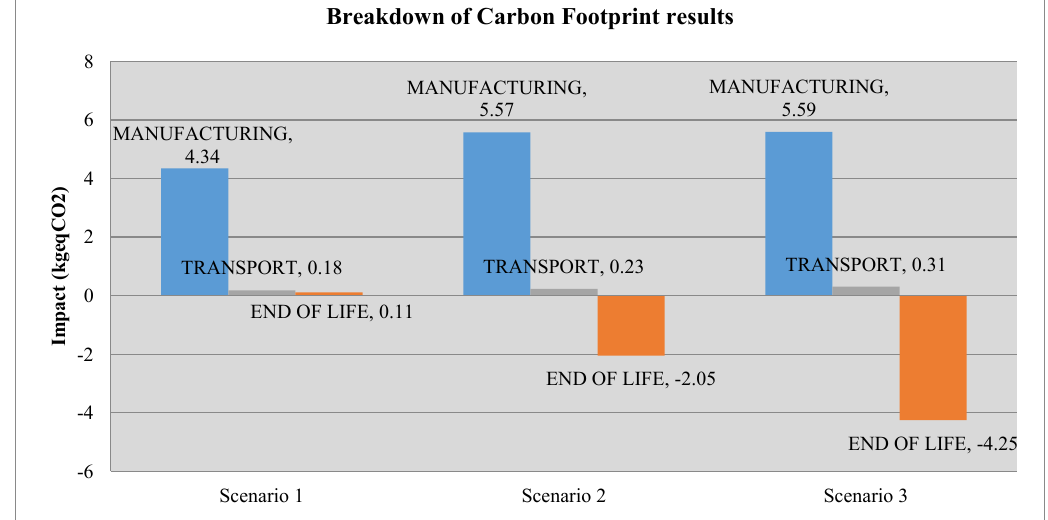
Figure 9. Breakdown of the carbon footprint